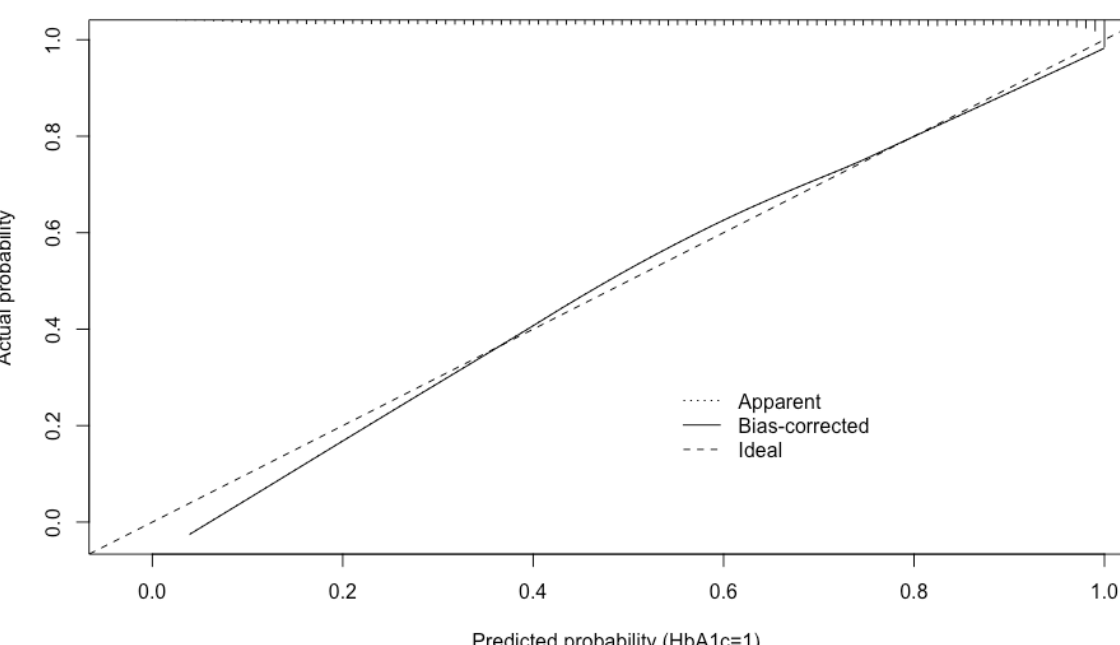
Figure 3. The calibration curve for PM2. HbA 1c : glycated hemoglobin. PM: predictive